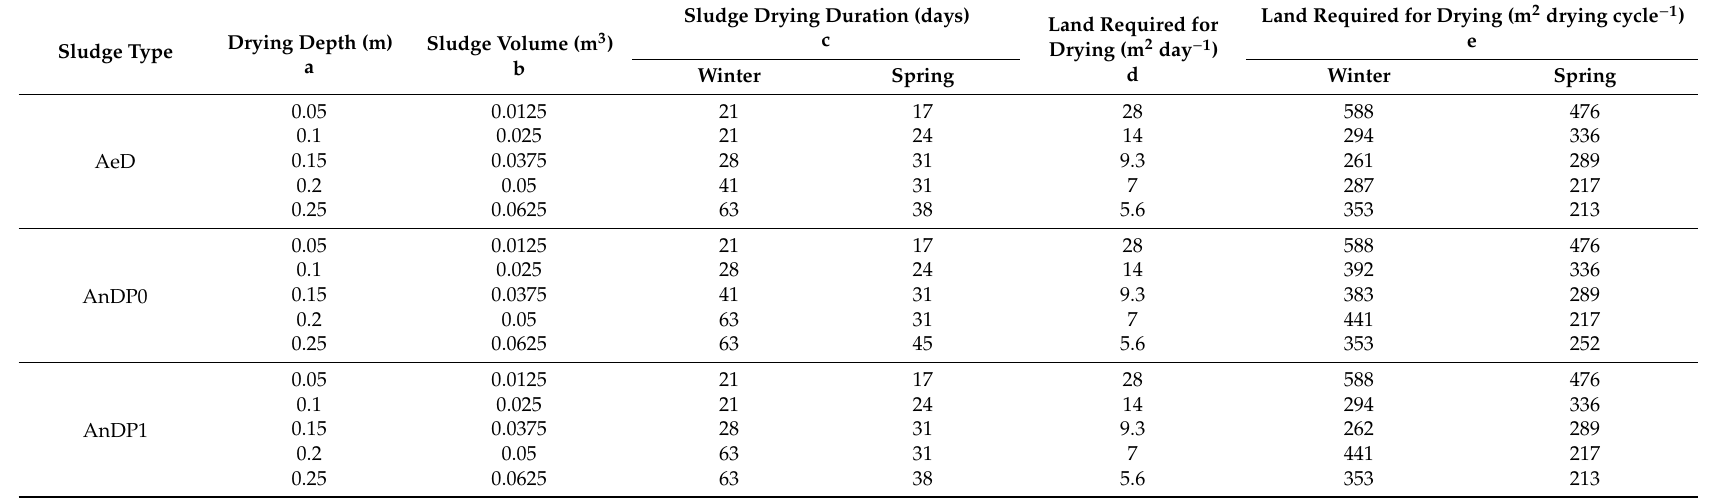
Table 4. Land size requirement and sludge drying duration for sludge drying per season based on sludge drying depth and sludge type.